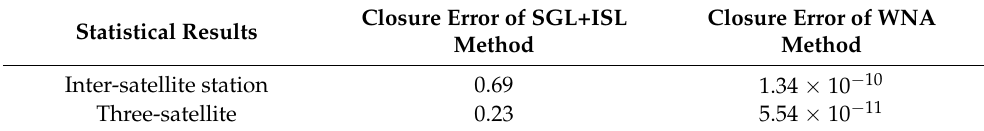
Table 4. RMS statistical results of closure errors (unit: